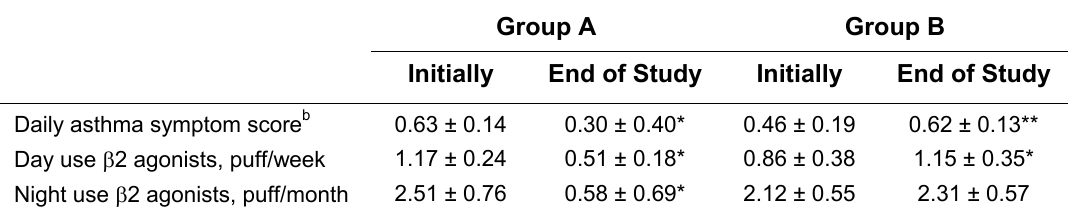
Group A Group B